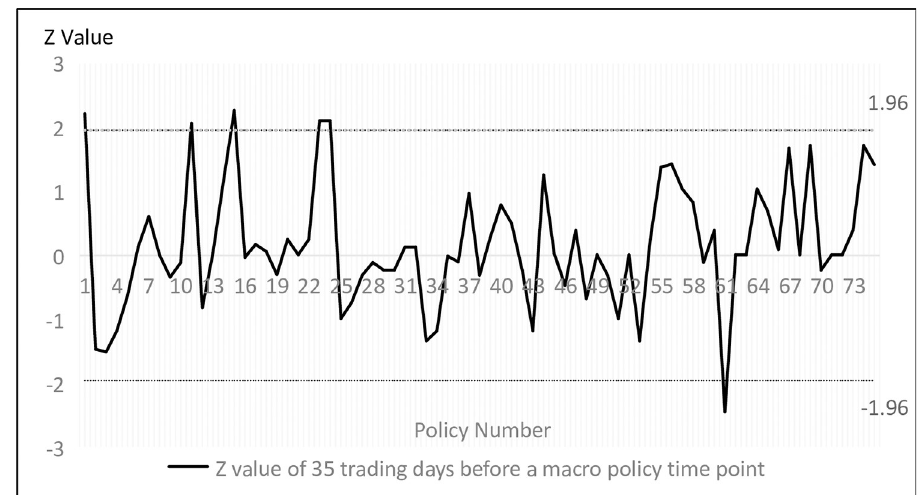
Fig 2. Run test results in 35 trading days before the policy event.